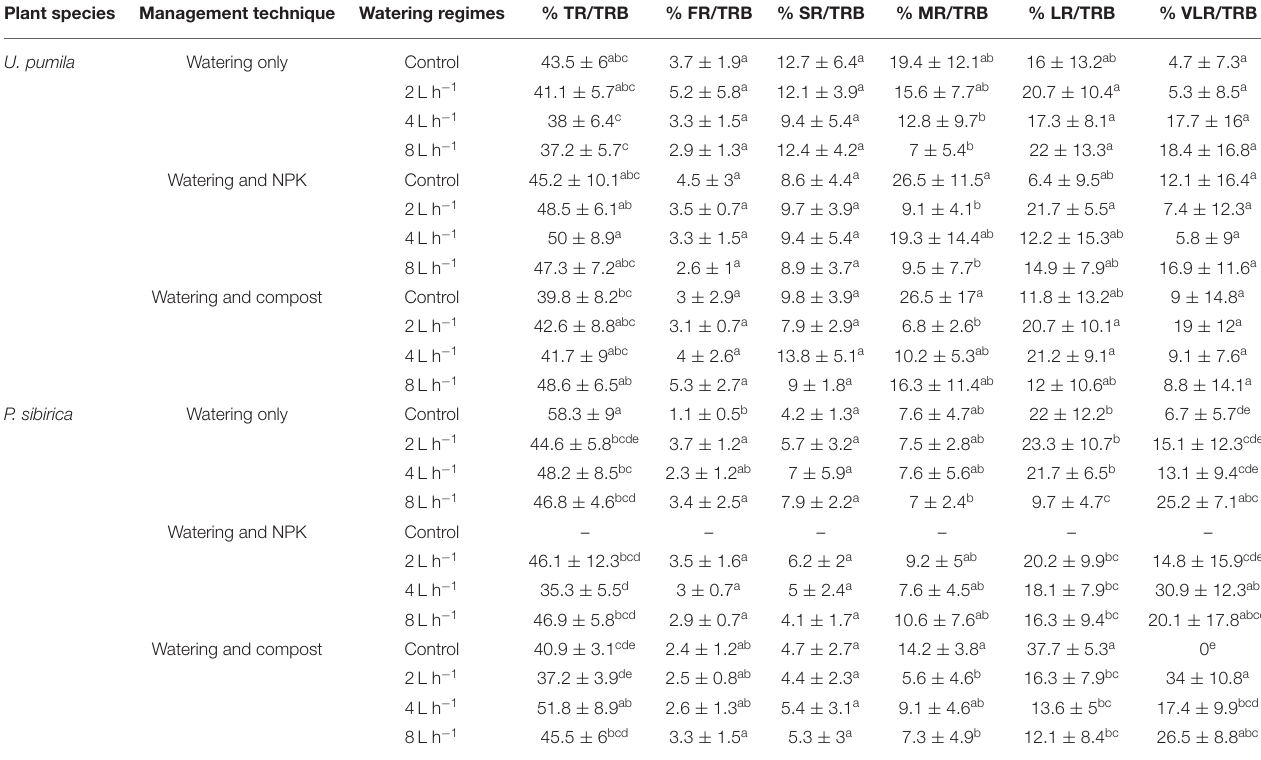
TABLE 4 | Ratio between biomass of a specific root class (TR, FR, SR, MR, LR, and VLR) and the biomass of the total root system (TRB) according to two studied plant species ( U. pumila and P. sibirica ), management techniques (watering only, watering + NPK, and watering + Compost), and different watering regimes. Plant species Management technique Watering